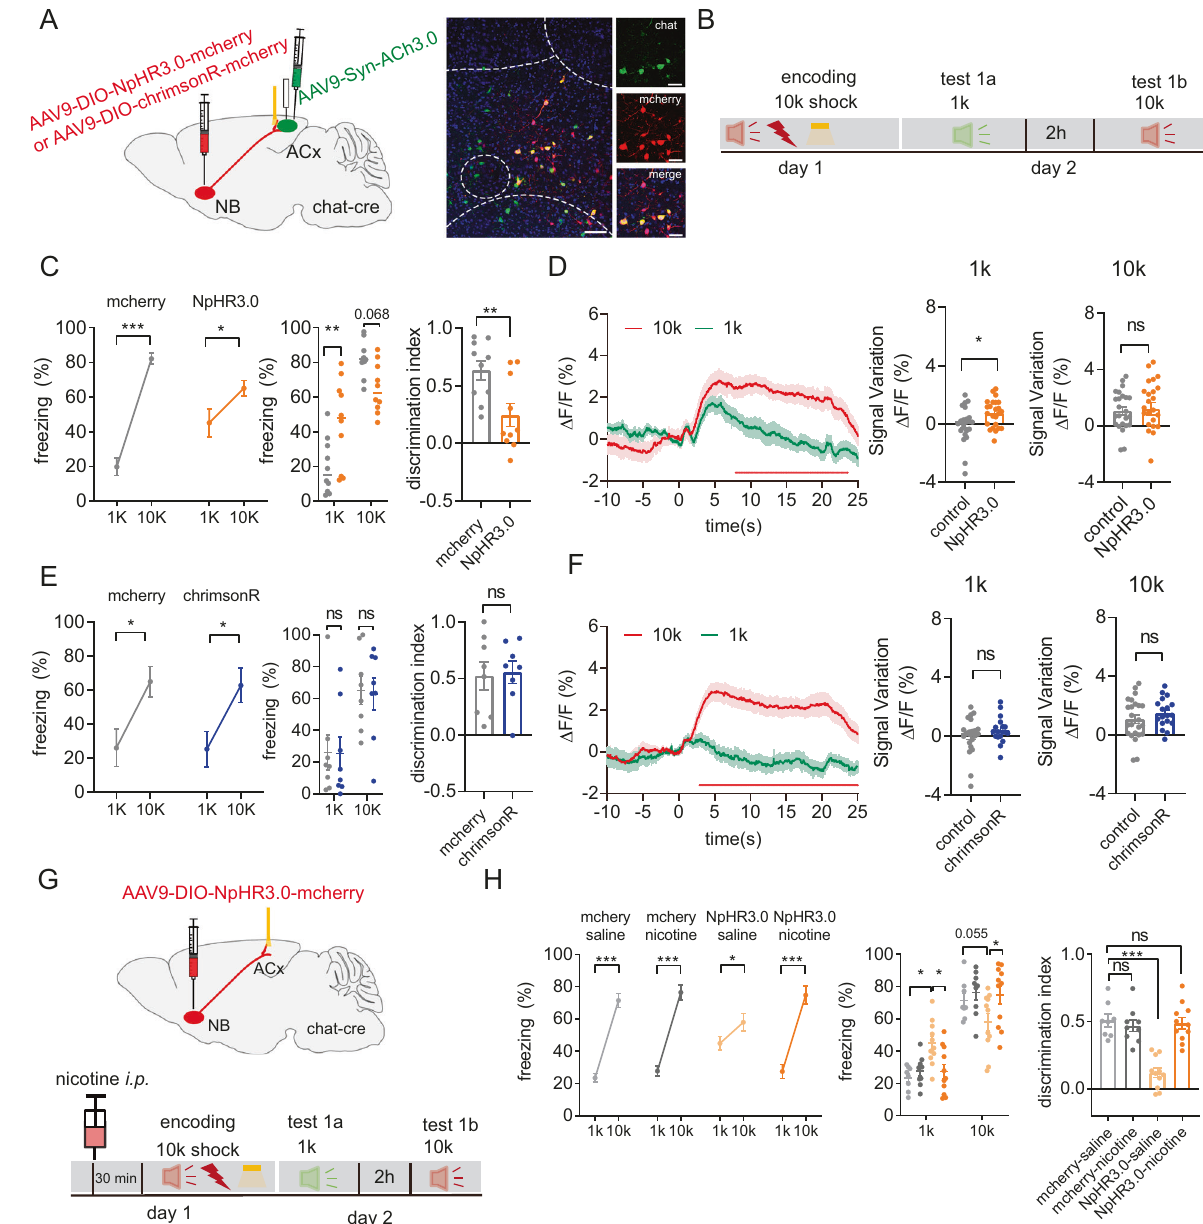
Fig. 2 Optogenetic manipulation of ACh signal in the ACx at the encoding stage regulates the DAFM. A Left, schematic of virus injection. In ChAT-cre mice, AAV9-DIO-NpHR3.0 or AAV9-DIO-ChrimsonR-mcherry was infused into the NB; AAV9-Syn-ACh3.0 was infused into the ACx. Right: Confocal images of coronal sections showing Cre + neurons (mcherry + ) in the NB of ChAT-cre mice were co-labeled with cholinergic neurons (green) Scale bar: 200 μ m; 20 μ m. B Behavioral design. C , E Percentage of the freezing time (left, middle) and discrimination index (right) in mice under inhibition ( C ) or activation ( E ) of ACx-projecting cholinergic neurons of the NB at the encoding stage ( C , NpHR3.0, n = 10, mCherry, n = 10; F (1, 36) = 13.96, P < 0.001; E ChrimsonR, n = 8; mCherry, n = 8; F (1, 28) = 0.0059, P = 0.94). D , F Left: The mean and SEM of the fl uorescence responses of ACh3.0 in the ACx of mice at day 2 receiving inhibition ( D ) or activation ( F ) of the ACx-projecting cholinergic neurons of the NB at the encoding stage. Red line indicated bins between the 10k and 1k trials with two-tailed unpaired t-test signi fi cance ( P < 0.05). Middle and Right: quanti fi cation of the average amplitude of increased signal against baseline between control (Fig. 1D, right) and NpHR3.0 (Fig. 2D, left) or ChrimsonR (Fig. 2F, left) group during the 1 kHz tone retrieval (middle) or 10 kHz tone retrieval (right). G Schematic of virus injection of AAV9-DIO-NpHR3.0-mcherry in the NB and behavioral design. H Percentage of the freezing time (left, middle) and discrimination index (right) in mice under either or both nicotine intraperitoneal injection and inhibition of ACx-projecting cholinergic neurons of NB at the encoding stage (mCherry-saline, n = 8; mCherry-nicotine, n = 9; NpHR3.0-saline, n = 11; NpHR3.0-nicotine, n = 11; freezing: F (3, 70) = 7.862, P < 0.001; discrimination index: F (3, 35) = 21.02, P < 0.001). Statistical tests: C , E , and H , freezing: two-way ANOVA with Bonferroni ’ s multiple comparisons tests. C , E discrimination index: unpaired two-tailed t -test. H discrimination index: one-way ANOVA with Bonferroni ’ s multiple comparisons tests. D , F signal variation: unpaired two-tailed Mann – Whitney- U -test. ns not signi fi cant; * P < 0.05, ** P < 0.01, *** P < 0.001. Data are presented as mean ±